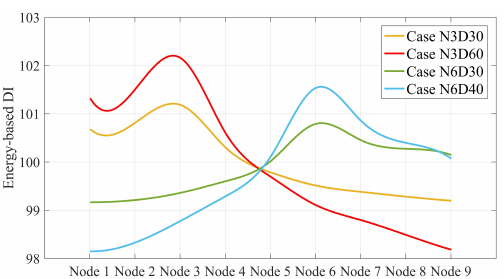
Figure 11. The spline of energy-based DIs along a simply supported beam subjected to moving sprung mass with a speed of 1.25 m/s for all single damage scenarios.